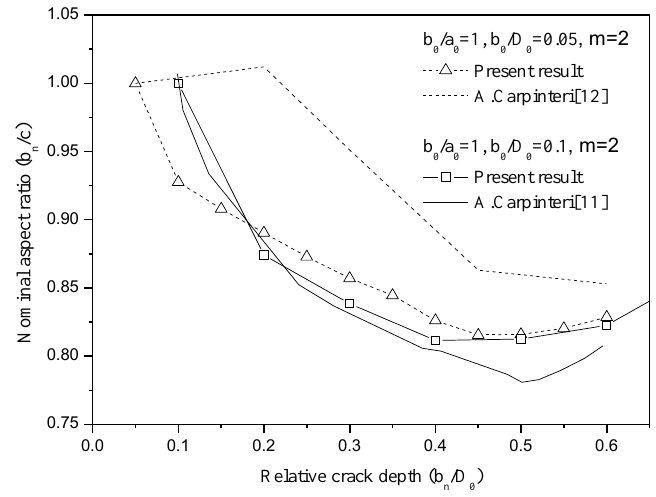
Figure 12. Crack propagation patterns compared with numerical solutions.